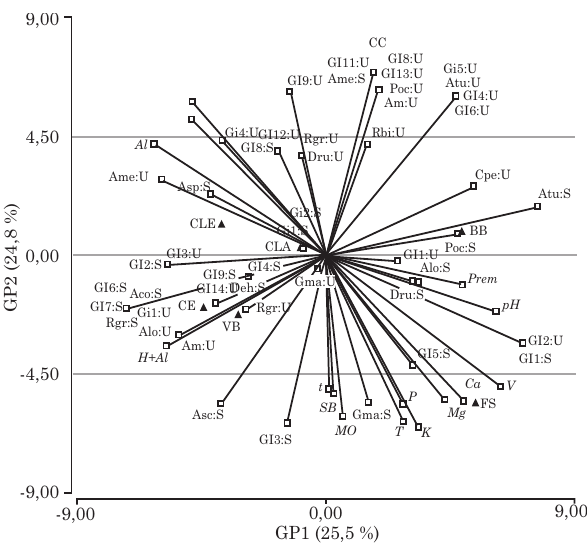
Figura 4. Diagrama de ordenação (PCA) das 37 espécies de FMA encontradas nas fitofisionomias do Pantanal da Nhecolândia, nos dois períodos amostrados. Ver quadro 5 para abreviaturas das